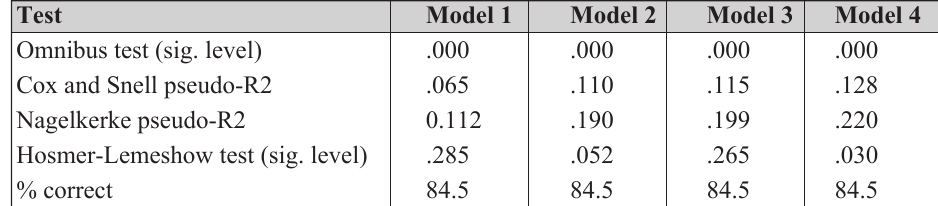
Table 01: Goodness-of-fit